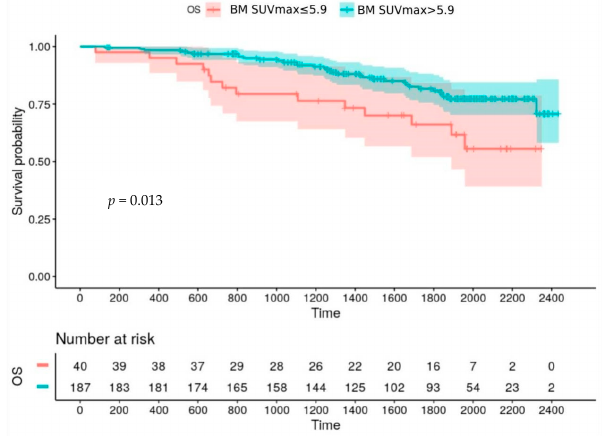
Figure 3. Overall survival according to BM SUVmax at baseline. Number of FLs and Deauville Score (DS) did not significantly affect survival. In a multivariate analysis including the treatment arm, R-ISS score, presence of EMD and bone SUVmax, absence of